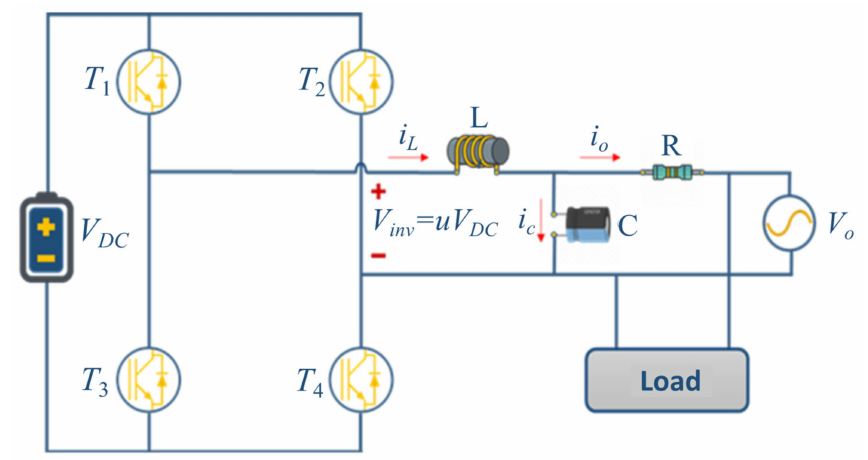
Figure 1. DC/AC Inverter Scheme with an LC